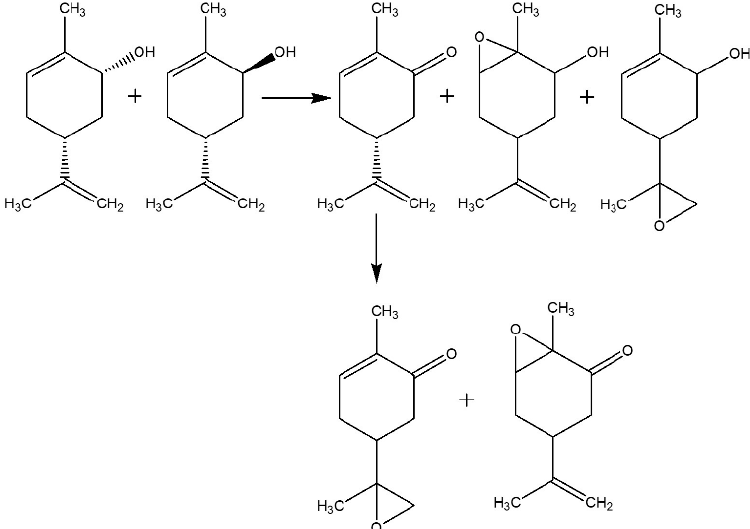
Figure 4. Oxidation scheme for carveol and carvone.